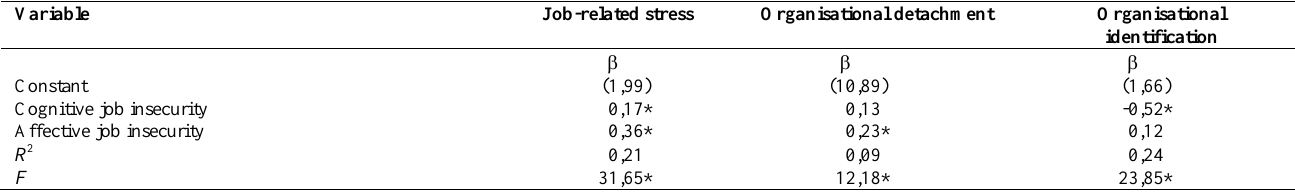
Table 3: Multiple regression analyses of job insecurity on job-related stress and organisational commitment Variable